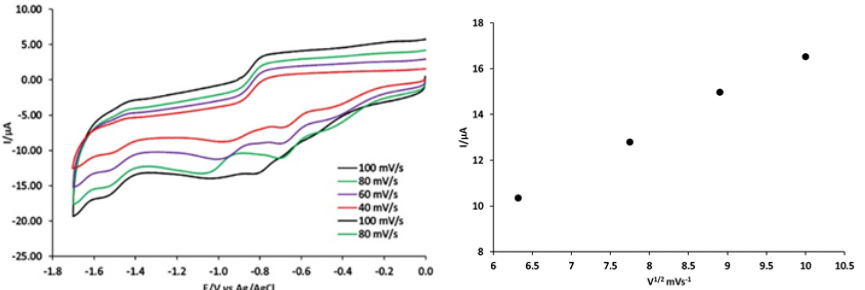
Figure 6. Cyclic voltammograms of 0.45 mM [Co(PLITSC-H) 2 ]BrNO 3 CH 3 OH at carbon electrode, at different scan rates in DMF containing 0.2M [NBu 4 ][BF 4 ] and ips versus the square-root of the scan rate.